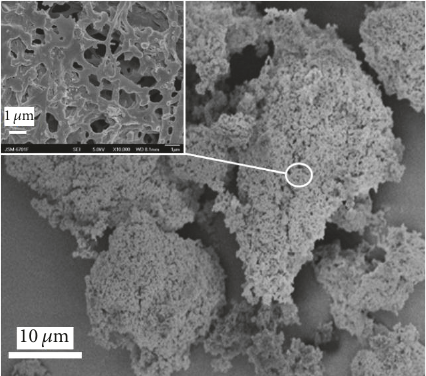
Figure 4: The SEM images of FK-GlyCu 60 .